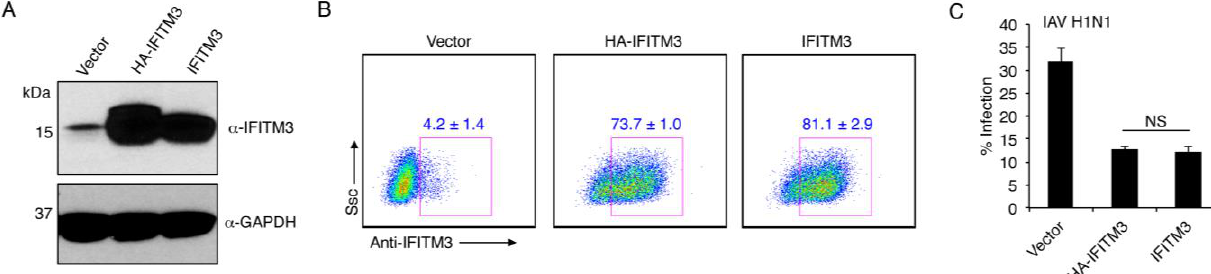
Figure 2. N-terminal HA-tagging of human IFITM3 does not affect its anti-influenza virus activity. ( A ) HEK293T cells were transfected with empty vector, or vector expressing human HA-IFITM3 or untagged human IFITM3. Cell lysates were examined by Western blotting with anti-IFITM3 antibodies and anti-GAPDH antibodies as a loading control; ( B ) Cells treated as in ( A ) were examined by flow cytometry staining with anti-IFITM3 antibodies. Cells are gated on IFITM3-positive cells and the blue numbers indicate the average of triplicate samples +/ − standard deviation. Ssc, side scatter; ( C ) Cells treated as in ( A ) and ( B ) were infected with IAV H1N1 strain PR8 at an MOI of 1.0 or mock infected for 6 h. Cells were analyzed for percent infection by flow cytometry based on anti-IAV nucleoprotein staining in comparison to mock-infected controls. Average percent infection of triplicate samples in a representative experiment was graphed. Error bars indicate standard deviation. Results are representative of more than 5 similar experiments. NS, not significant by Student’s t test.